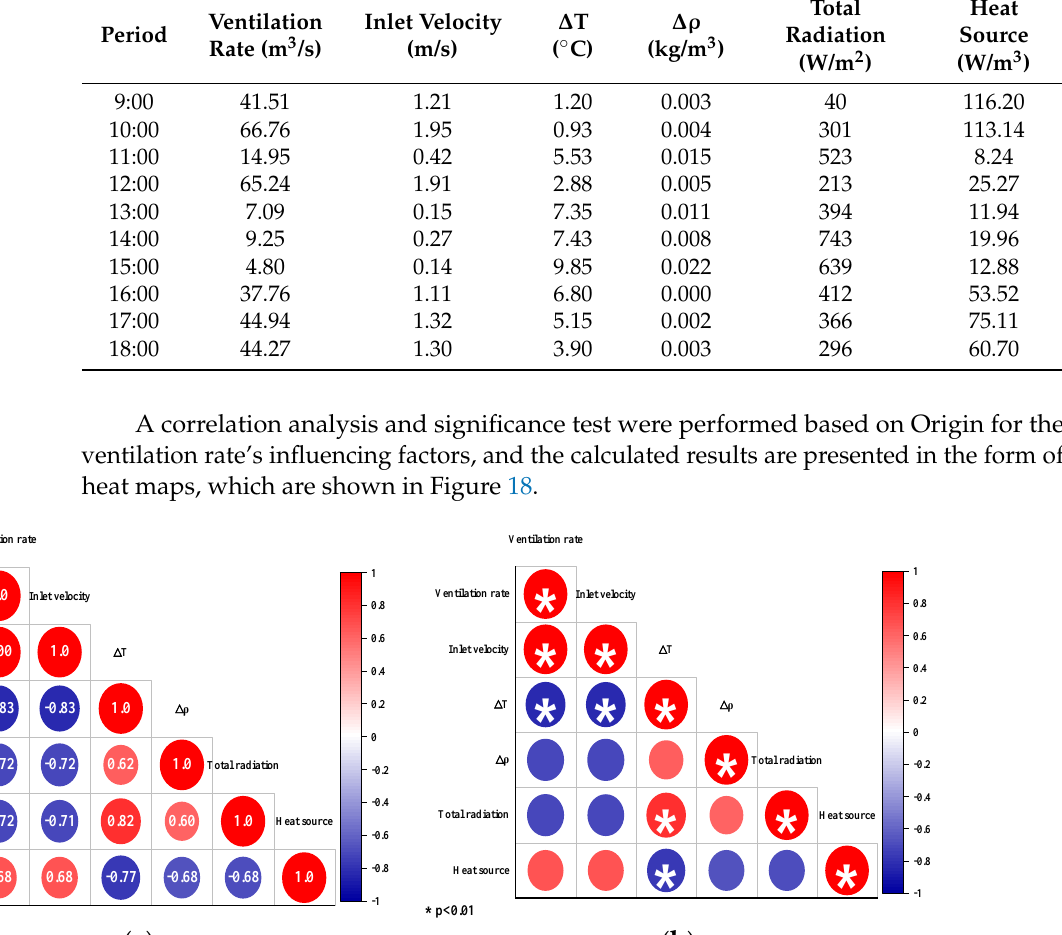
Table 6. Values calculated for ventilation − rate − related factors.